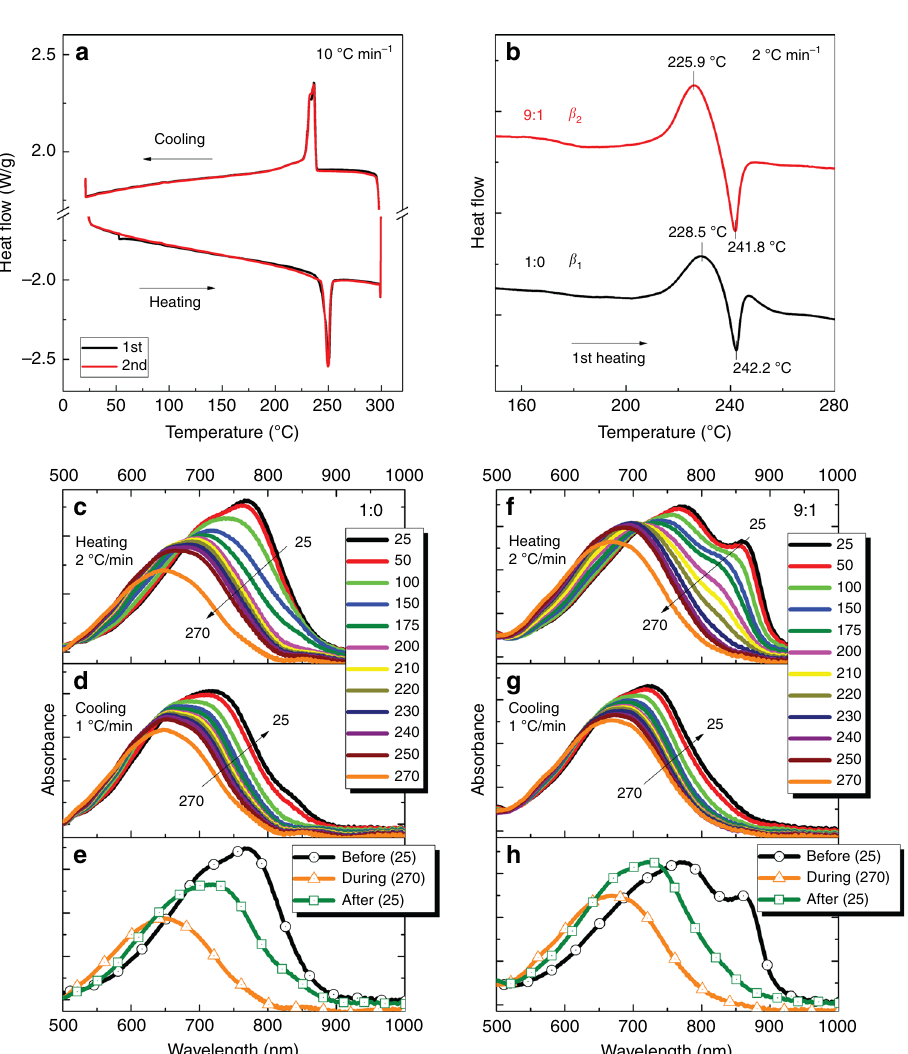
Fig. 6 Thermal behavior of polymorphs. a Standard DSC thermograms of D-PDPP4T-HD precipitated from chloroform in methanol. The scanning rate is 10 °C min − 1 . b The fi rst heating DSC thermogram for D-PDPP4T-HD re-dissolved and dried from different solvents. The scanning rate is 2 °C min − 1 . c , d , e , f , g , h , In situ optical absorption during heating and cooling of D-PDPP4T-HD thin fi lms spin-coated from CF:TCB 1:0 ( c , d , e ) and 9:1 ( f , g , h ). N 2 atmosphere is utilized to protect the polymer fi lms. The heating and cooling rates are 2 °C min − 1 and 1 °C min − 1 , respectively. The bottom panels compare the optical absorption before and after thermal